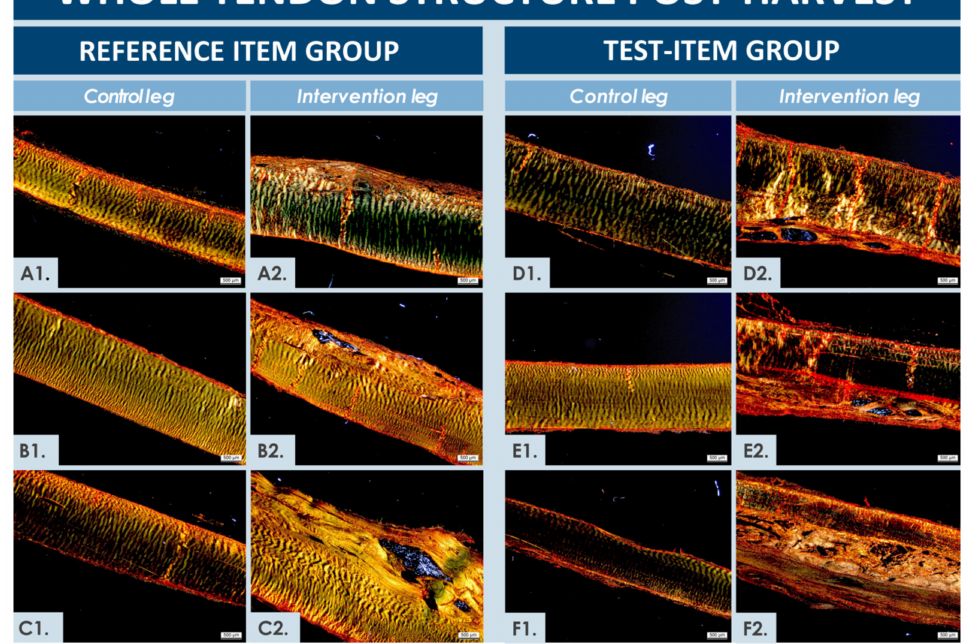
Figure 5. Full-thickness structure of the operated and treated or contralateral untreated rabbit patellar tendons, harvested, stained with Picrosirius Red, and observed under polarized light. ( A1 – F1 ) The contralateral untreated tendons all presented normal structures. ( A2 – F2 ) The healing process was on-going after 6 weeks for the operated and treated tendons in both groups. The artificial defect zones were recognizable due to relatively less organized collagen tissue, localized relative tissue enlargement, and presence of small cavities in some cases ( B2,C2 ). Remaining biomaterial may be observed in operated tendons having received the cell therapy ( D2 – F2 ). It is to note that, based solely on the photographic data presented herein, the treated reference item group (i.e., A2 – C2 ) shows better global structure of the harvested tendons than the treated test-item group (i.e., D2 – F2 ). However, this aspect is to be highly relativized, based on the variability between animal test-subjects, the available and presented histological pictures, and the alternative complementary readouts used for the assessment of all operated and treated tendons. Particularly, the full integration of all investigated readouts (i.e., macroscopic and microscopic investigation, histology, variety of observed tissue zones) was in fine retained for the discussion and conclusions drawn about the safety of the proposed cell therapy in the rabbit model of interest. Scale bars = 500 µ